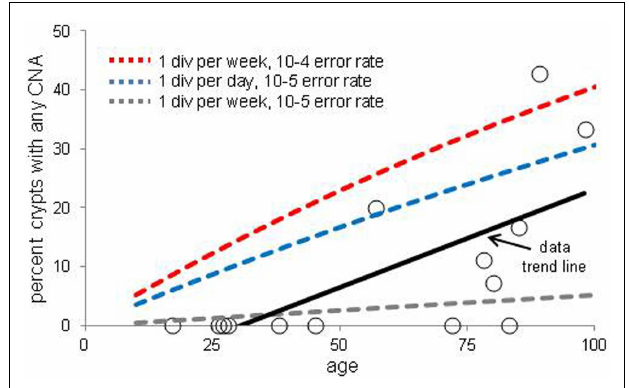
FIGURE 3 | Percent of crypts with any chromosome copy number alteration versus age . Circles are averaged experimental data and the dotted lines indicate calculated mutation frequencies with different combinations of mutation and stem cell division rates. A regression analysis indicates that the experimental increase in CNA frequency with age is significant ( p = 0.01).The calculated mutation frequencies do not account for the lag between a mutation in a stem cell and the time needed to become detectable by niche succession.